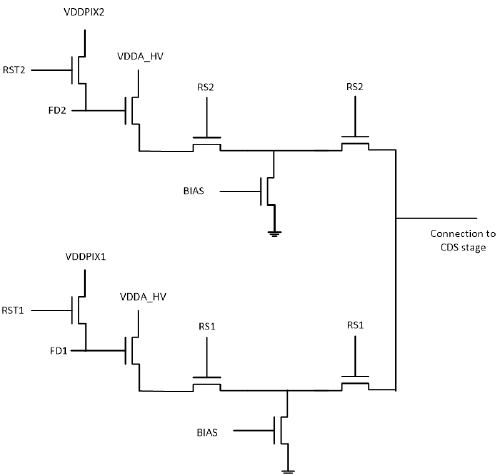
Figure 2. Cross-section of the TDI-CCD. The black line divides the anti-blooming shift region and the TDI shift region.